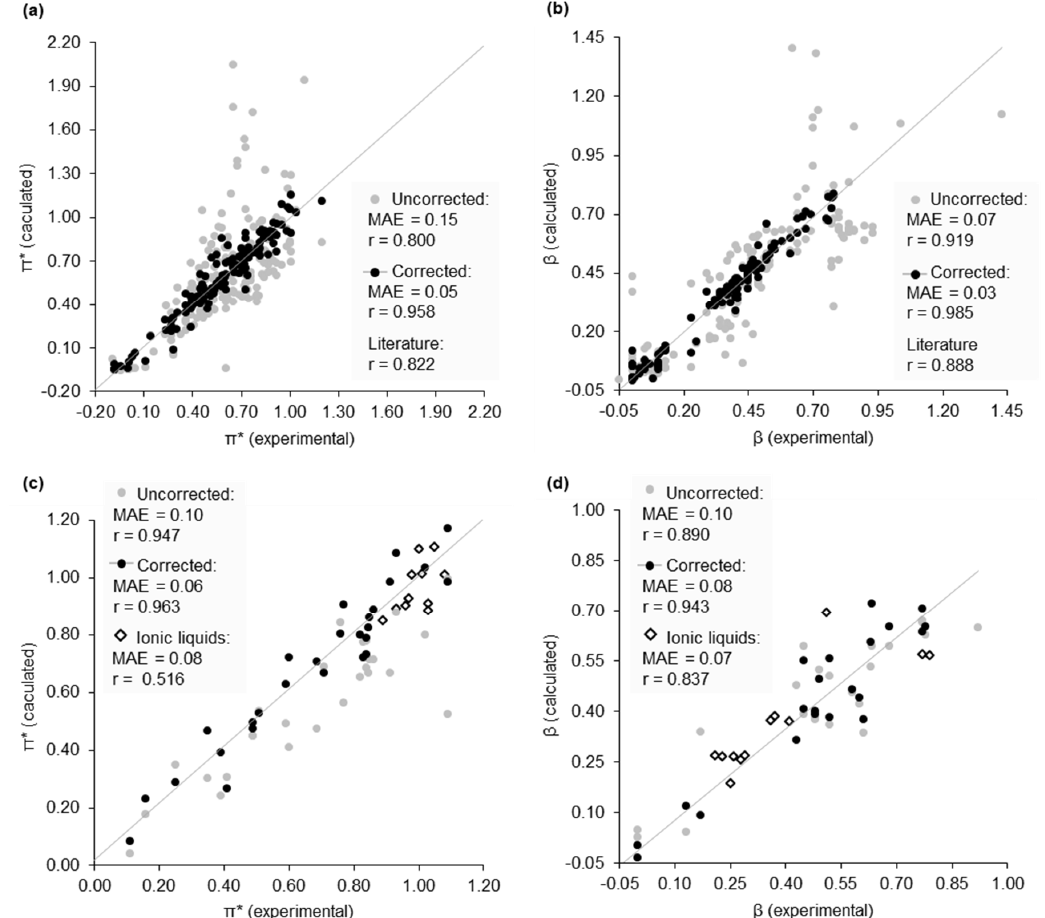
Figure 3. Calculated Kamlet–Abboud–Taft (KAT) parameters correlated to experimental data, accompanied by an error analysis and reference to literature methods [26]. ( a ) π * calculations, primary dataset; ( b ) β calculations, primary dataset; ( c ) π * calculations, secondary dataset, and ionic liquids; ( d ) β calculations, secondary dataset and ionic liquids.